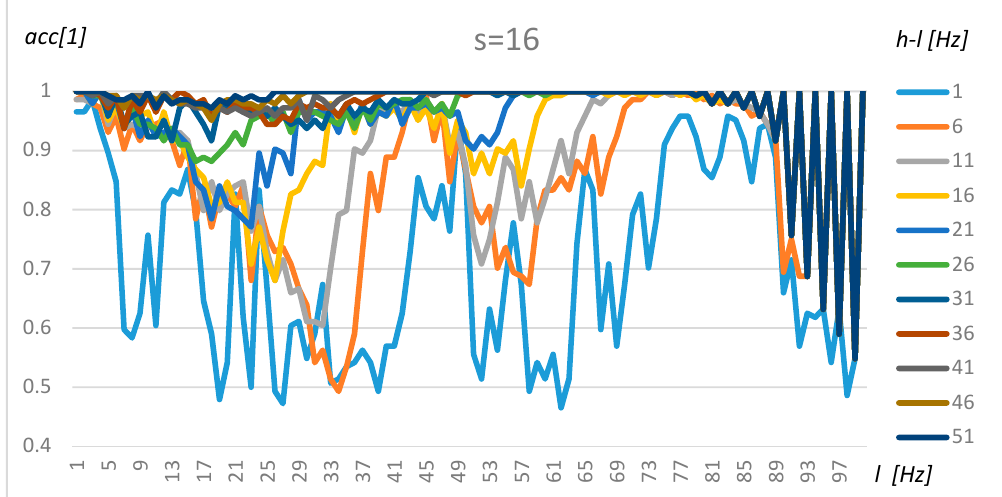
Figure 10. The accuracy value for Transformer 1, s = 16, and various l and h parameters.